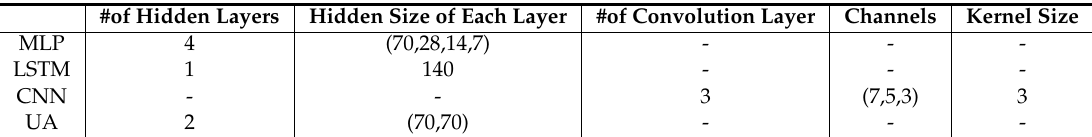
Table 2. Hyper-parameters of each